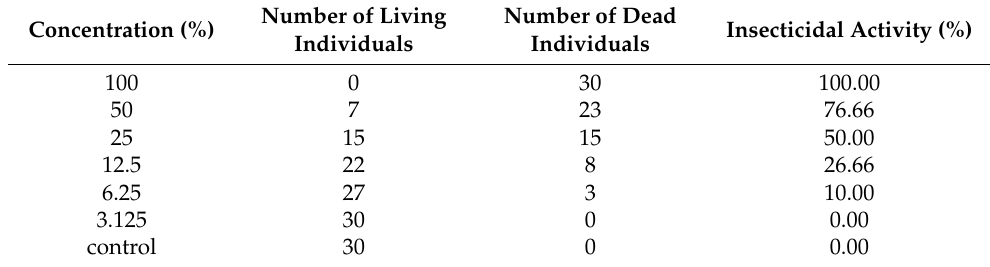
Table 9. Anti-insect activity of FEO.